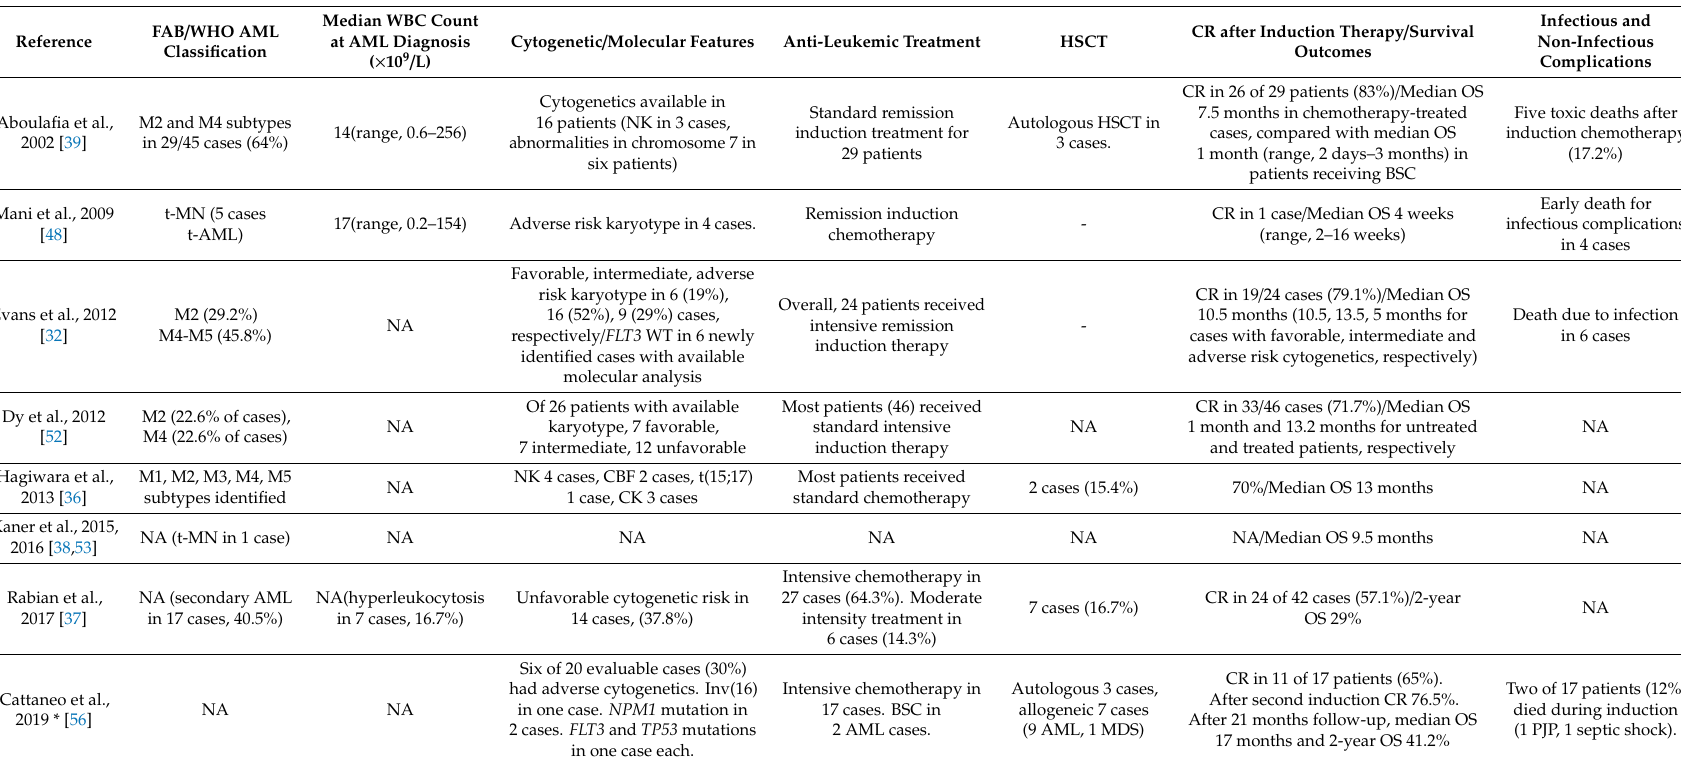
Table 2. Clinical features and treatment outcomes of acute myeloid leukemia (AML) cases in HIV +